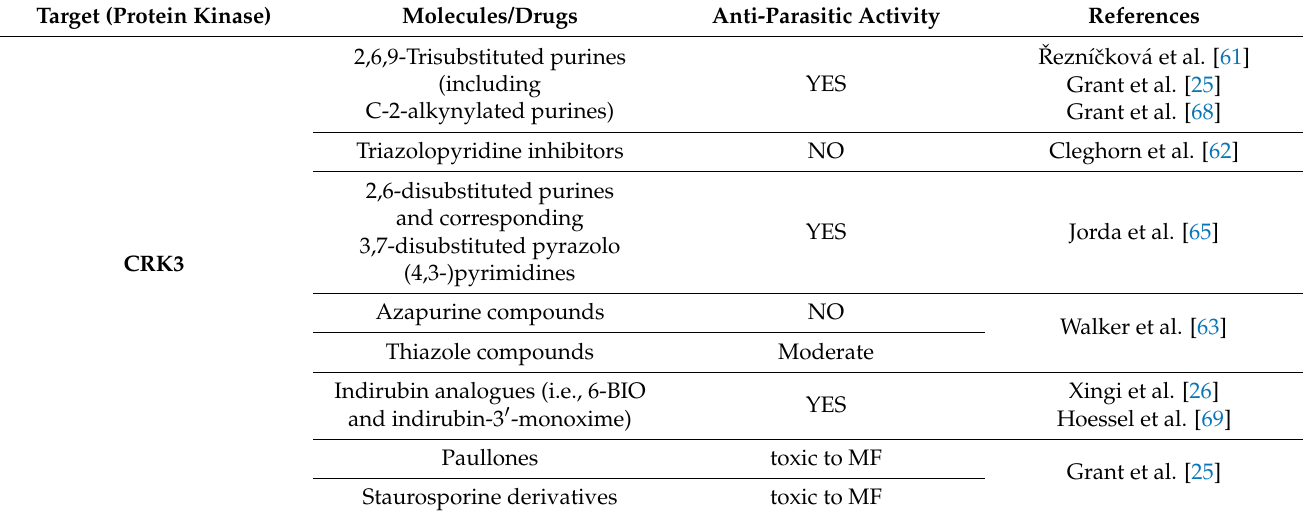
Table 1. Identified inhibitors targeting leishmanial eukaryotic Protein Kinases. Target (Protein Kinase) Molecules/Drugs Anti-Parasitic